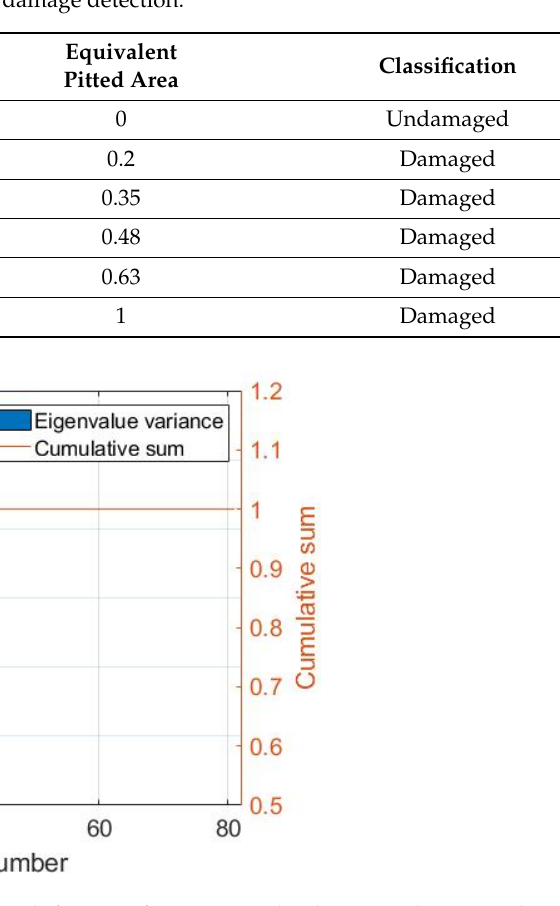
16 of 22 Table 4. Training-set composition for damage detection. # Observations